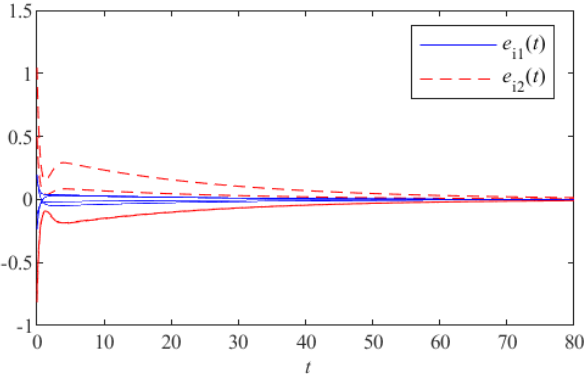
Figure 1. e i ( t ) withthe control gains d = 0.51 and k = 0.01 in Example 1.